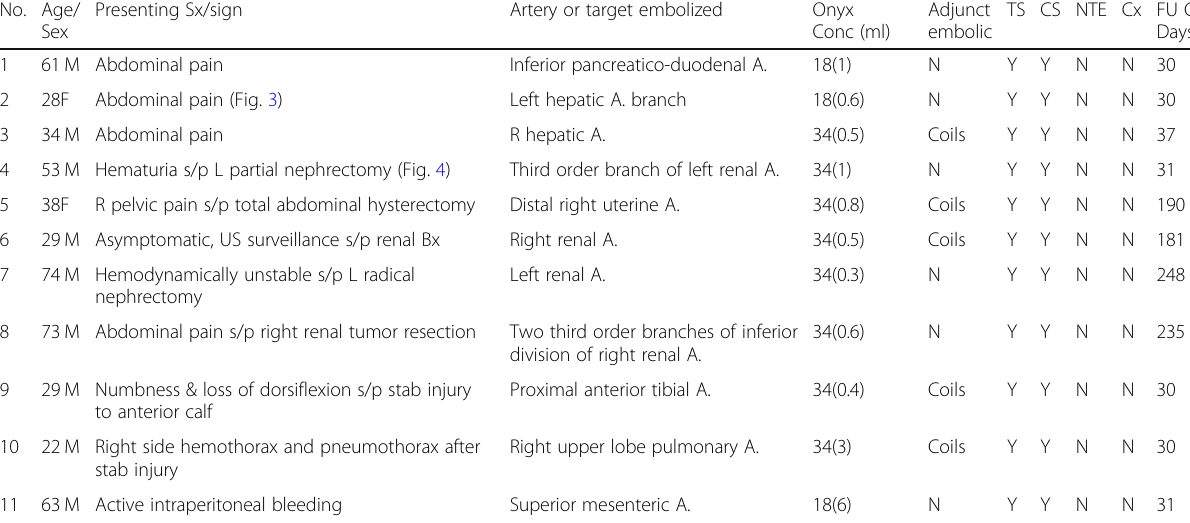
Table 7 Etiology: